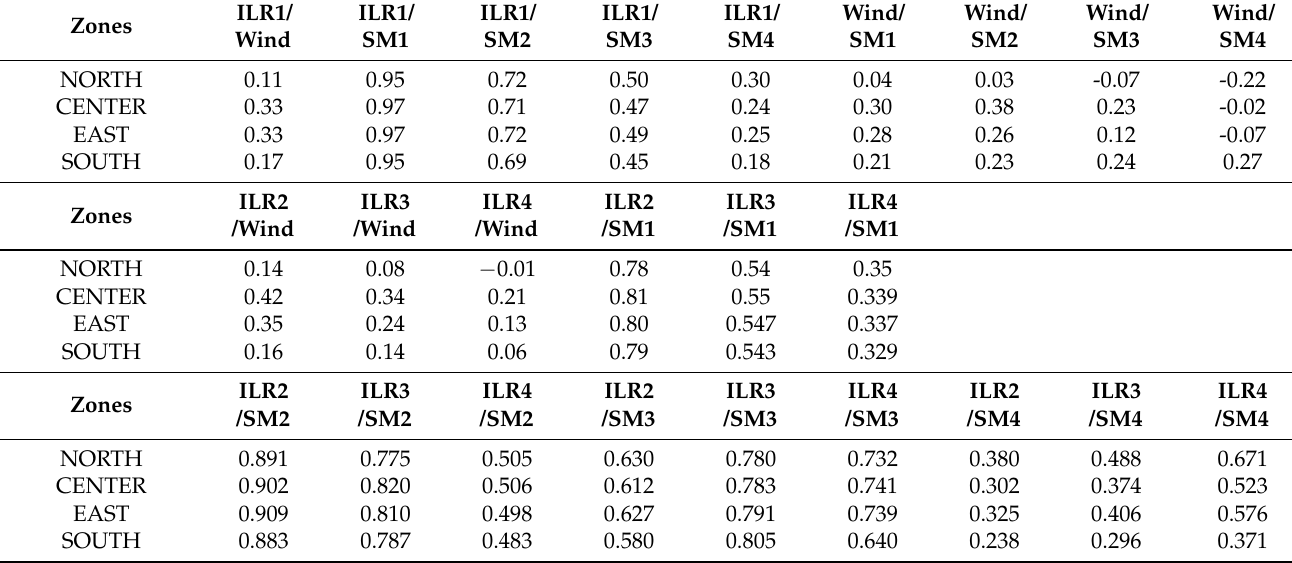
Table A2. Estimates of the correlations between the predicted capacity factors and the inverse of the demand in the same region over the year 2018. ILR1 or SM1: without storage; ILR > 1 or SM > 1: with increasing levels of storage.